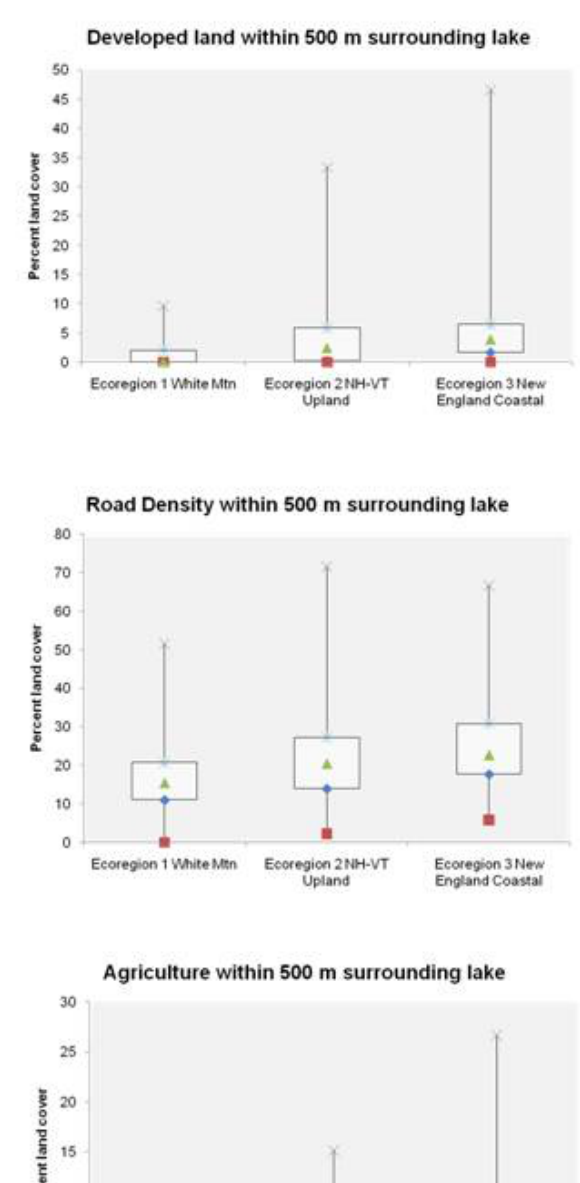
Fig. 6. Proportion of developed land cover composition within 150- and 500-m zones surrounding lakes within each ecoregion. Blue diamond = 25% quartile, red square = minimum value, green triangle = median value, purple x = maximum value, blue star = 75%